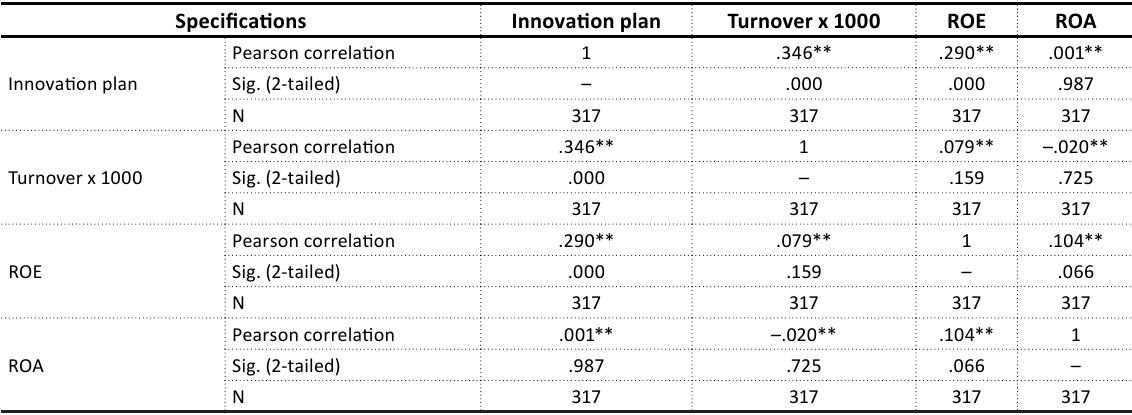
Source: Processed by authors using